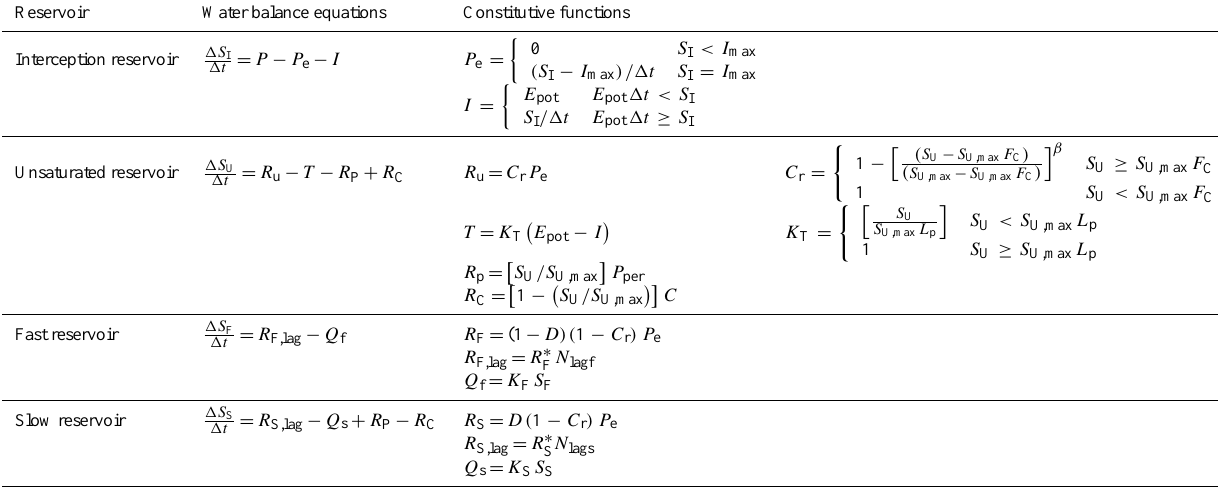
Table 2. Water balance equations and constitutive functions used in FLEX A . Reservoir Water balance equations Constitutive